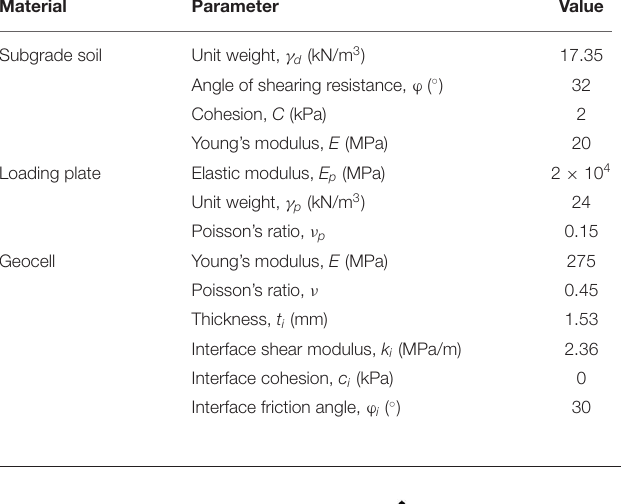
TABLE 5 | Properties of different materials used in modeling for dynamic loading condition. Material